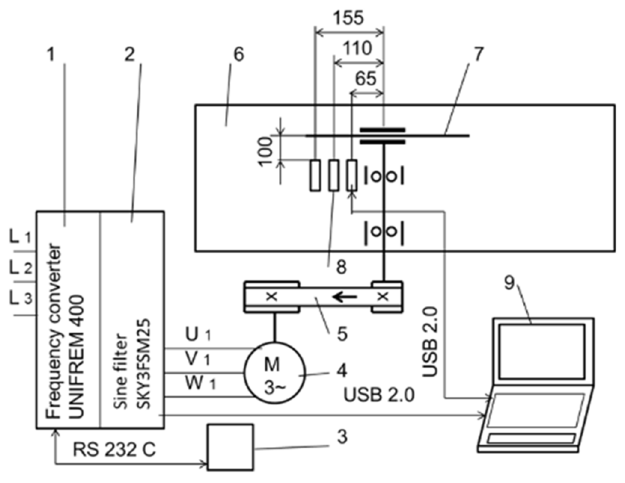
Figure 4. A circular saw including a device for measuring the cutting power and the surface temperature of the circular saw blade, where 1 is frequency converter (UNIFREM 400 007 M); 2 is sine filter (SKY3FSM25); 3 is control panel with digital display connected to the frequency converter via RS232C serial interface; 4 is electric motor; 5 is V-belt transmission; 6 is frame circular saw with a shaft mounted in radial bearings; 7 is circular saw blade with clamping flanges; 8 is three positions of the Calex PUA8-CF temperature sensor; 9 is PC (personal computer).